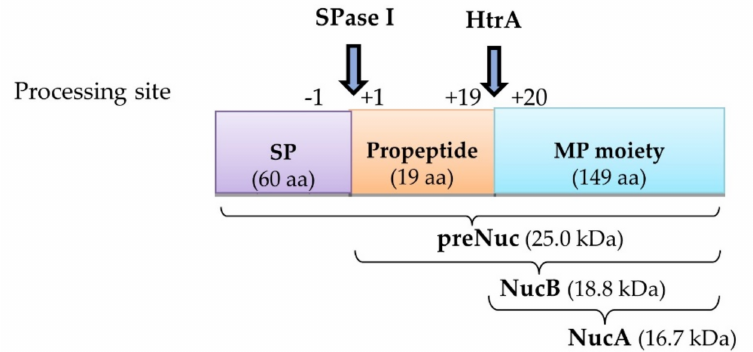
Figure 1. Schematic diagram showing different NUC forms produced following translocation. In L. lactis , the synthesized precursor NUC (preNuc), which consists of signal peptide (SP), native propeptide, and mature protein (MP) regions, matures into NucB through cleavage of the SP by SPase I (at processing site position − 1). It was subsequently further processed into NucA through the removal of the 19-aa propeptide (at processing site position +19), postulated to be due to the activity of surface protease HtrA, before finally being secreted to the extracellular